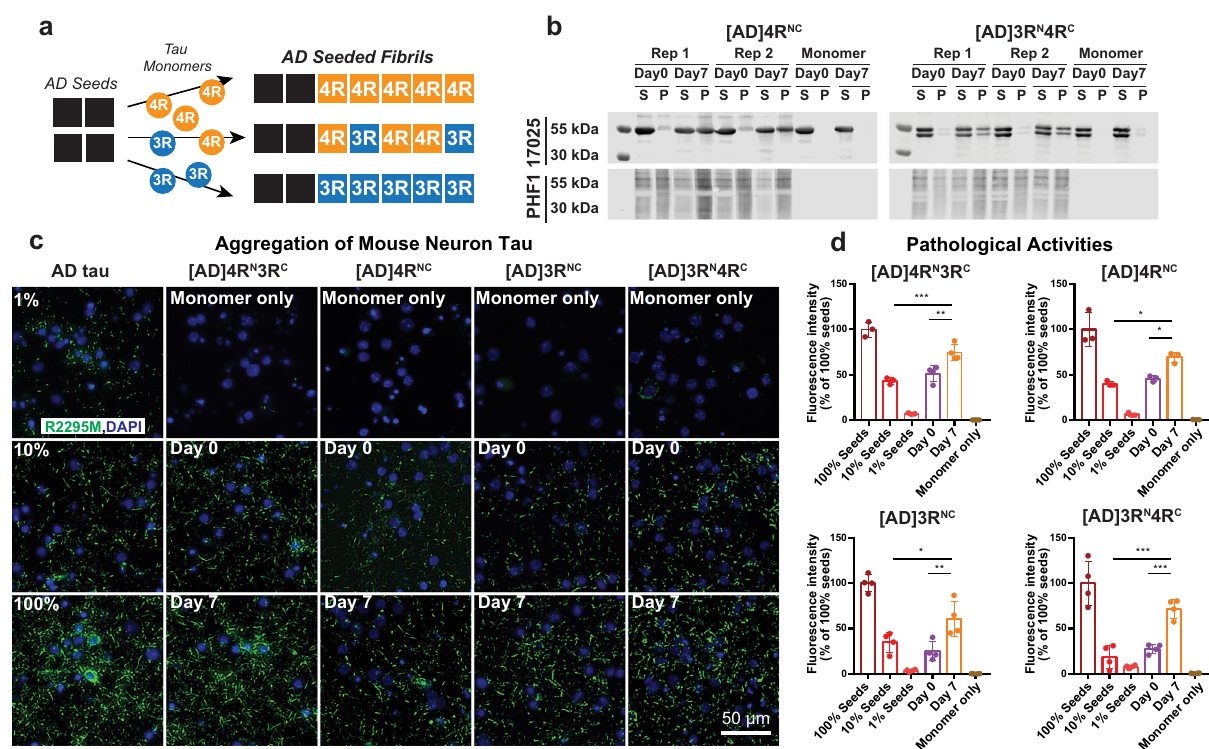
Fig. 1 Isotopically labeled recombinant tau seeded with AD tau fi laments conserves the AD pathogenic activity in wild-type neurons. a Schematic of seeding recombinant 0N4R and 0N3R tau with AD tau extracts. b Sedimentation assay shows that recombinant tau monomers are incorporated into insoluble mass after 7 days of shaking with 10% AD tau seeds. Samples were fractionated into supernatant (S) and pellet (P) by ultracentrifugation. Tau species were revealed by the 17,025 antitotal tau antibody and PHF1 anti-phospho-tau antibody. Aliquots of replicate (Rep) samples 1 and 2 were collected for biochemical characterization at day 0 and day 7 (the end) of the fi brillization reaction. Reactions without AD tau seeds (monomer-only) were used as control to assess the extent of self- fi brillization. Full blots can be found in Supplementary Fig. 1. c Immunocytochemistry shows AD-tau-seeded recombinant tau fi brils recapitulate the pathogenicity of AD tau in primary neurons. Wild-type primary hippocampal neurons were transduced with AD tau or seeded tau fi brils. Aggregated tau pathology was revealed by R2295M anti-mouse tau antibody (green) and DAPI (blue) that stains cell nuclei. Seeded samples are AD-tau-seeded fi brils containing a 1:1 mixture of 15 N-labeled 4R tau and 13 C-labeled 3R tau, 4R-only tau, 3R-only tau, and a 1:1 mixture of 15 N-labeled 3R tau and 13 C-labeled 4R tau. d Quanti fi cation of fl uorescence in c shows that the seeded fi brils at day 7 have increased pathogenicity compared to day 0. As expected, day 0 samples (10% AD tau seeds with monomers) showed similar pathogenicity levels to the 10% tau seeds without monomers. All values were normalized to the 100% AD tau seeds. Statistical analysis was performed using one-way ANOVA. Multiple comparison between groups was conducted using Tukey post hoc test. On the graph, * P < 0.05, ** P < 0.01, *** P < 0.001 in the multiple comparison tests. Error bars are presented as standard deviation (SD). Each data point stands for one biological repeat: [AD]4R N 3R C n = 3, [AD]4R NC n = 3, [AD]3R NC n = 4, [AD] 3R N 4R C n =